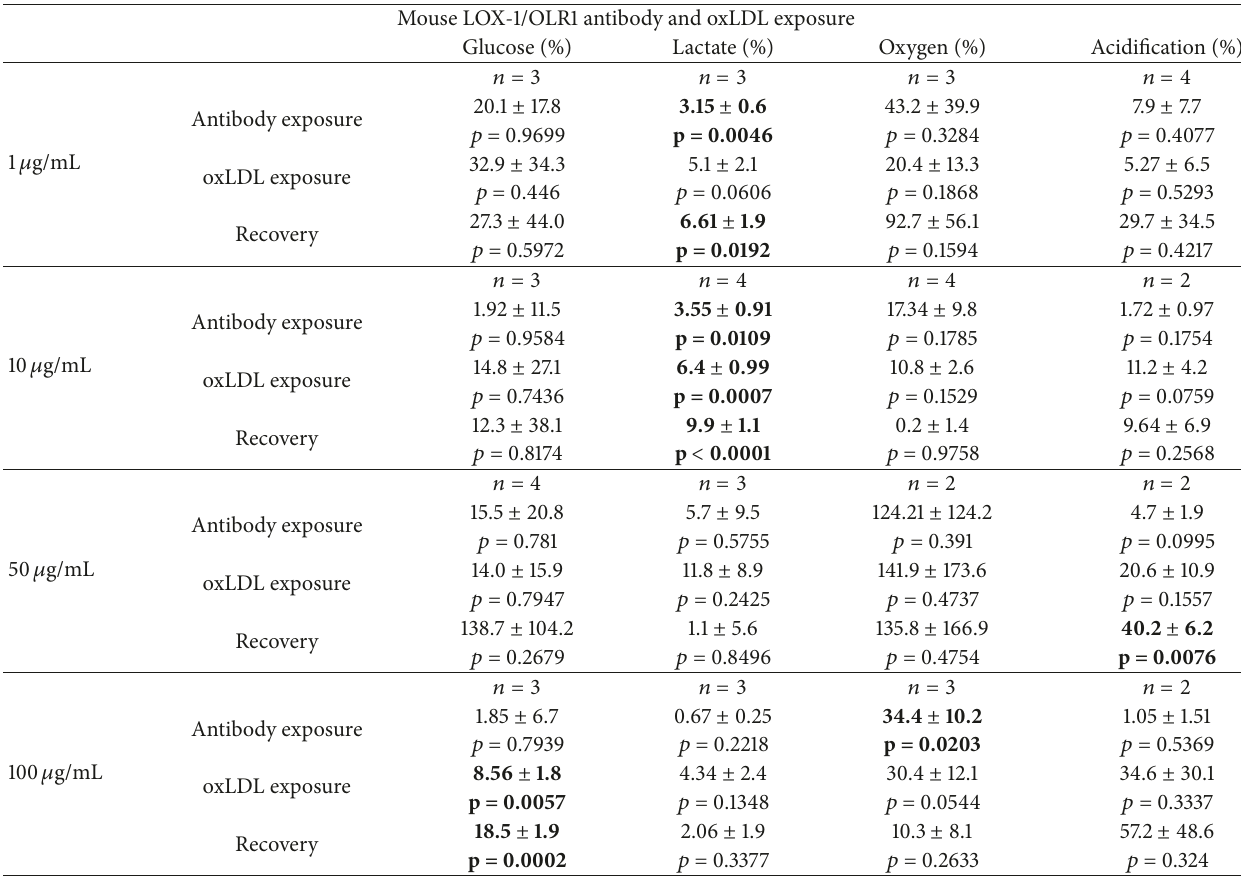
Table 9: Metabolic effects of mouse LOX-1/OLR1 antibody 10 min exposure followed by 6min exposure to Kalen high oxLDL on macrophages. Mean peak MAMP height changes and standard errors for each experimental condition during antibody exposure, oxLDL exposure, and recovery are shown. All 𝑝 values are calculated based on peak height versus 10min average basal value prior to exposure. Terms in bold are representative of 𝑝 < 0.05 , indicating statistical